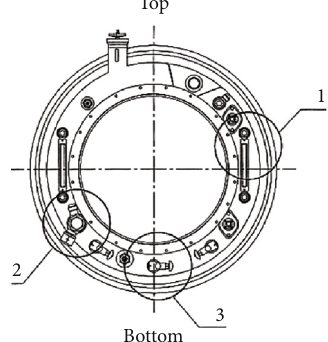
Figure 1: Zones a ff ected by the burner fl ame